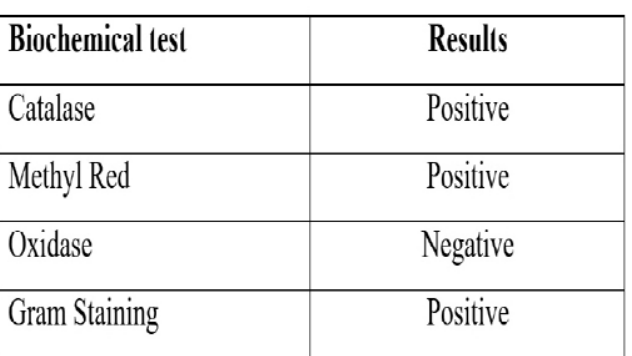
antibiotics amoxicillin, ampicillin and penicillin.